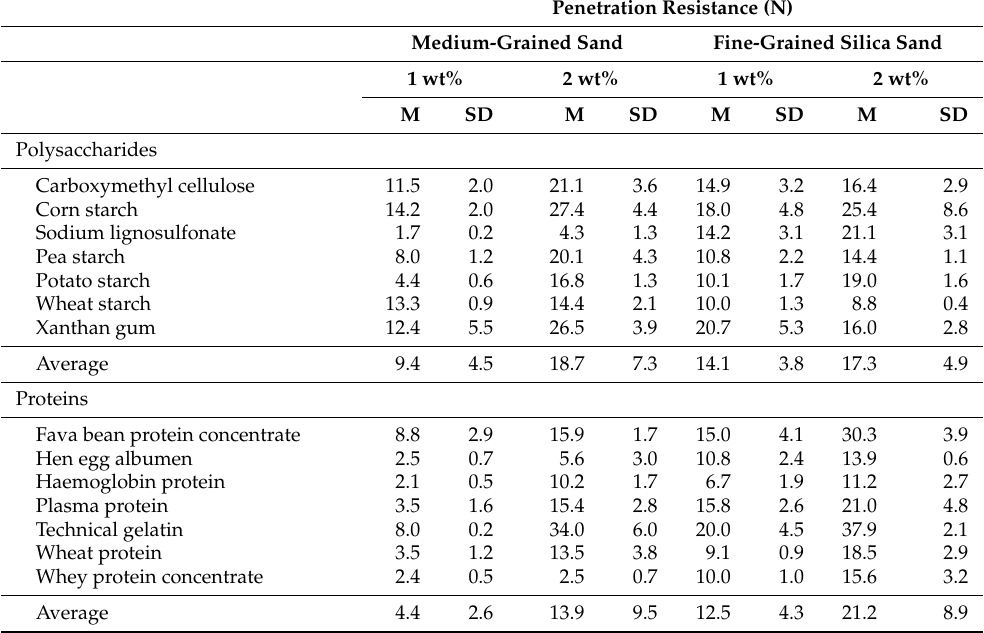
Table A3. Penetration resistance of medium-grained and fine-grained silica sand samples treated at biopolymer concentrations of 1 and 2 wt% (XG = 0.25 and 0.50 wt%). Tests were performed in triplicates ( n = 3), with M = mean and SD = standard deviation. The water-treated control group achieved a penetration resistance of 1.5 N (SD = 0.1) on medium-grained sand and 1.7 N (SD = 0.2) on fine-grained silica